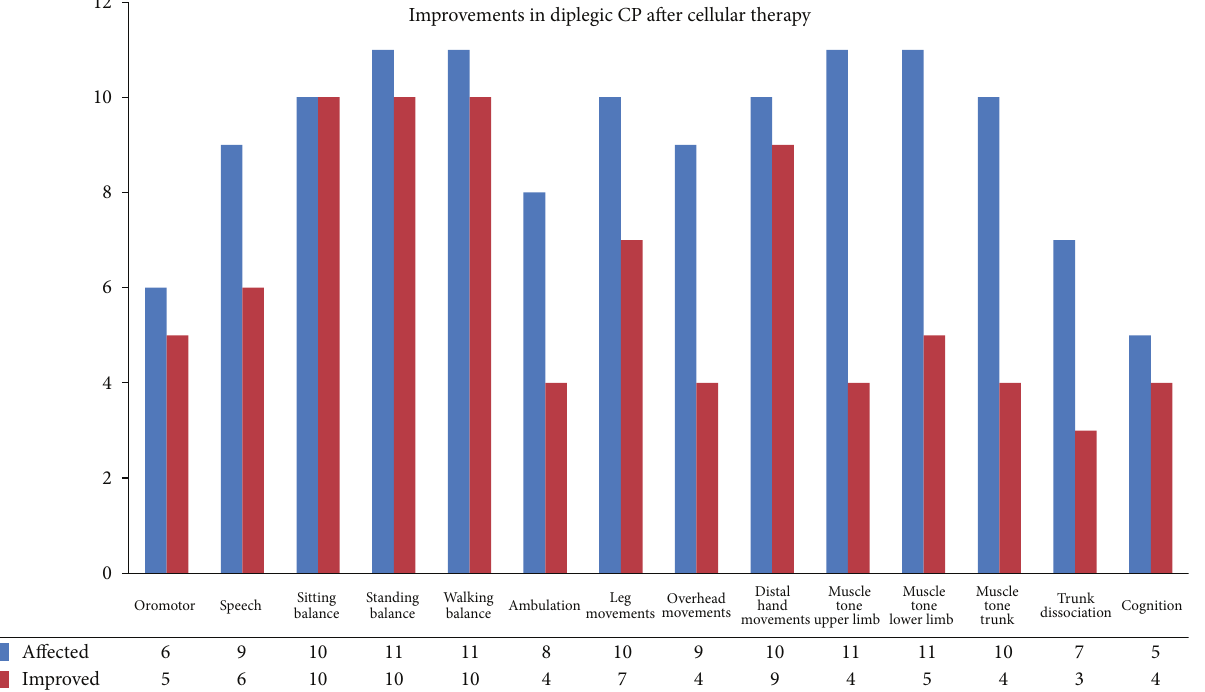
Figure 1: Improvements in diplegic CP: graph demonstrating symptomatic improvements in diplegic cerebral palsy after cellular therapy.